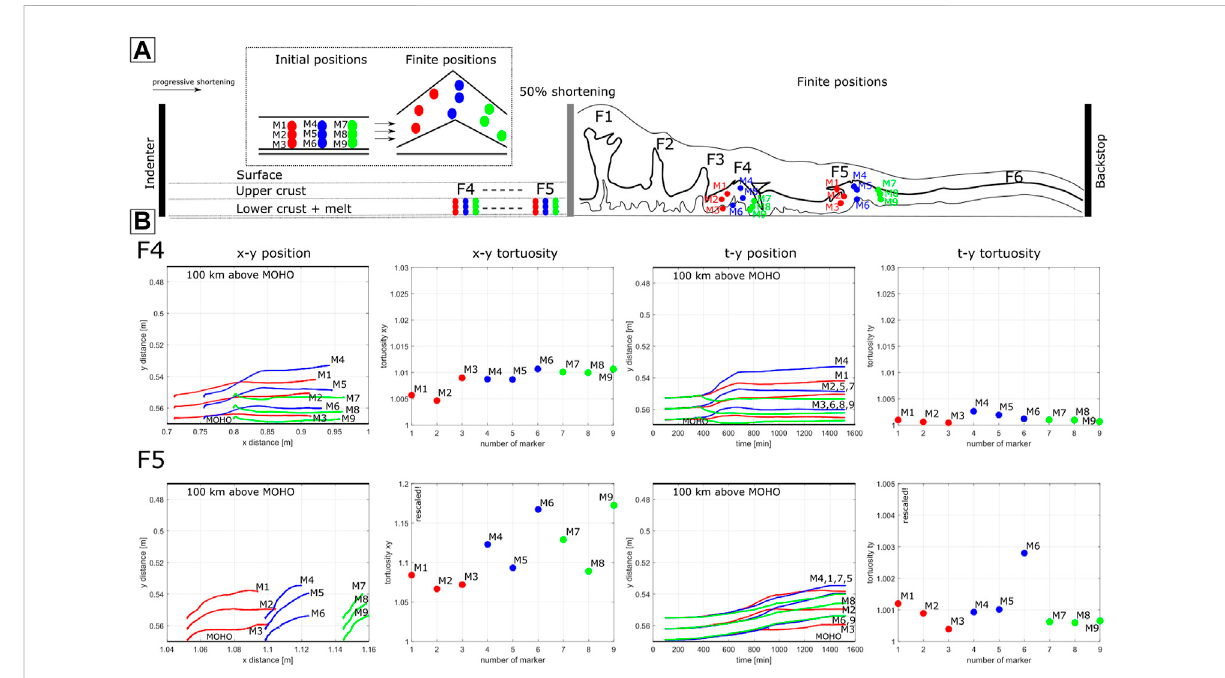
FIGURE 7 Numerical analysis of fold kinematics in Experiment #8 (folds F4 and F5). For details see caption associated to Figure 6 and main